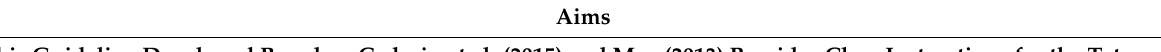
Table 1. A structured problem-based learning guideline for small group